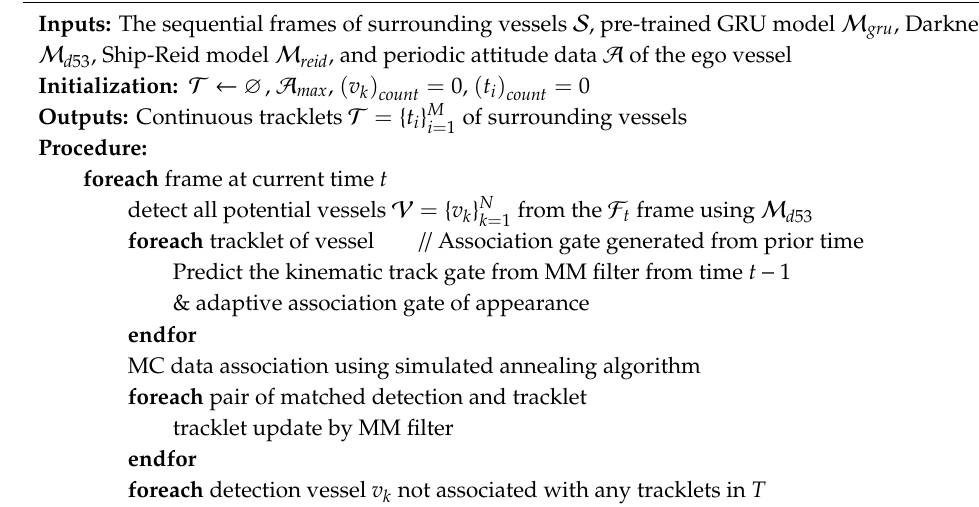
Algorithm 1: The proposed M 3 C tracking by detection Inputs: The sequential frames of surrounding vessels S , pre-trained GRU model M gru , Darknet53 model M M A of the ego d 53 , Ship-Reid model reid , and periodic attitude data